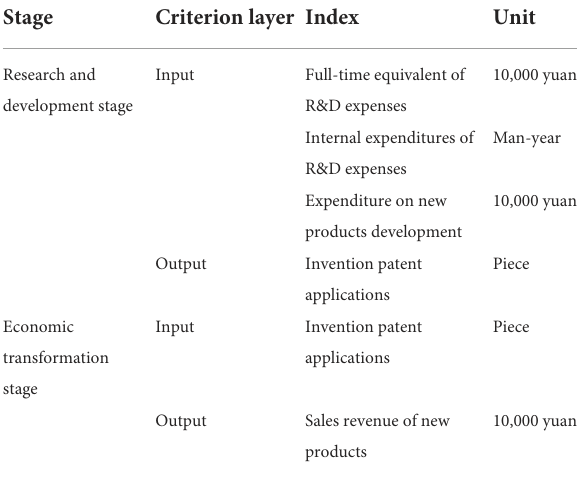
TABLE 1 Descriptive statistics of the